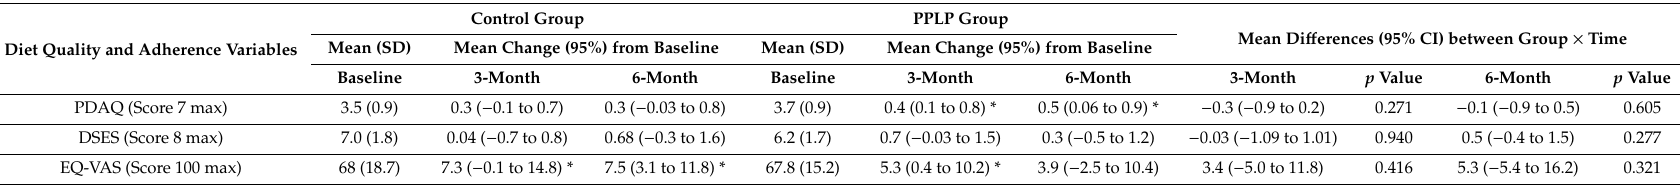
Table 4. Diet quality, self-e ffi cacy, and quality of life change from baseline to 3- and 6-month follow ups, with di ff erences in within and between groups over time.